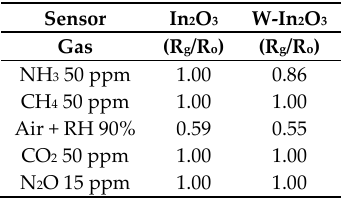
Table 1. Results of cross sensitivity tests for In 2 O 3 and W-In 2 O 3 sensors at 75